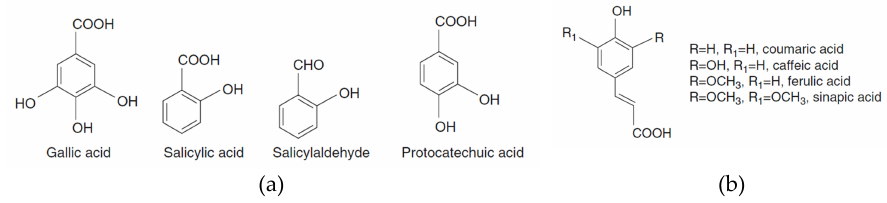
Figure 1 . Chemical structures of hydroxybenzoic acids (a) and hydroxycinnamic acids (b). Figure 1. Chemical structures of hydroxybenzoic acids ( a ) and hydroxycinnamic acids ( b ). According to Khadem and Marles [16], gallic acid has antineoplastic and bacteriostatic activities, and salicylic acid exerts anti-inflammatory, analgesic, antipyretic, antifungal, and antiseptic properties. Protocatechuic acid has also been described as having several